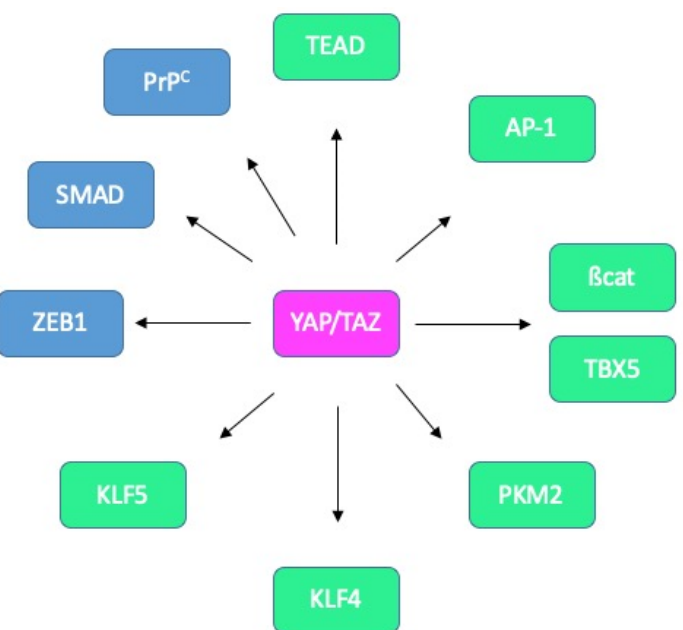
Figure 7. Known and potential binding partners of YAP / TAZ in CRC. Interactions between YAP / TAZ and TEAD, AP-1, ß-catenin / TBX5, PKM2, KLF4 and KLF5 (green) have been reported in CRC cells. Candidate partners in CRC cells (blue) include ZEB1, SMADs and PrP C .